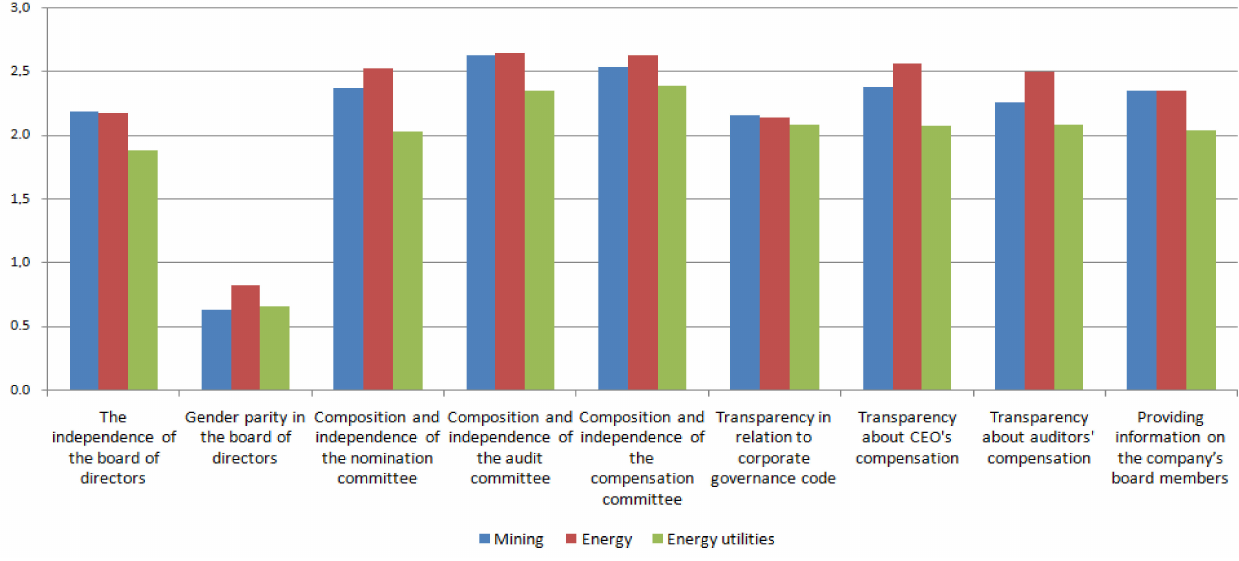
Figure 4. Comparison of mean values of grades obtained in corporate governance indicators by mining, energy, and energy utilities